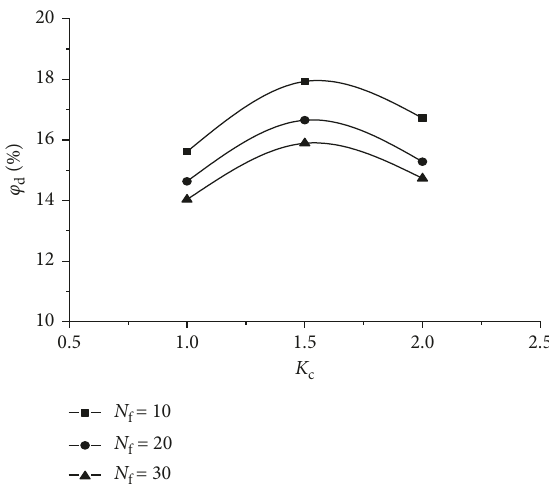
Figure 5: Curves of dynamic internal friction angle with con- solidation